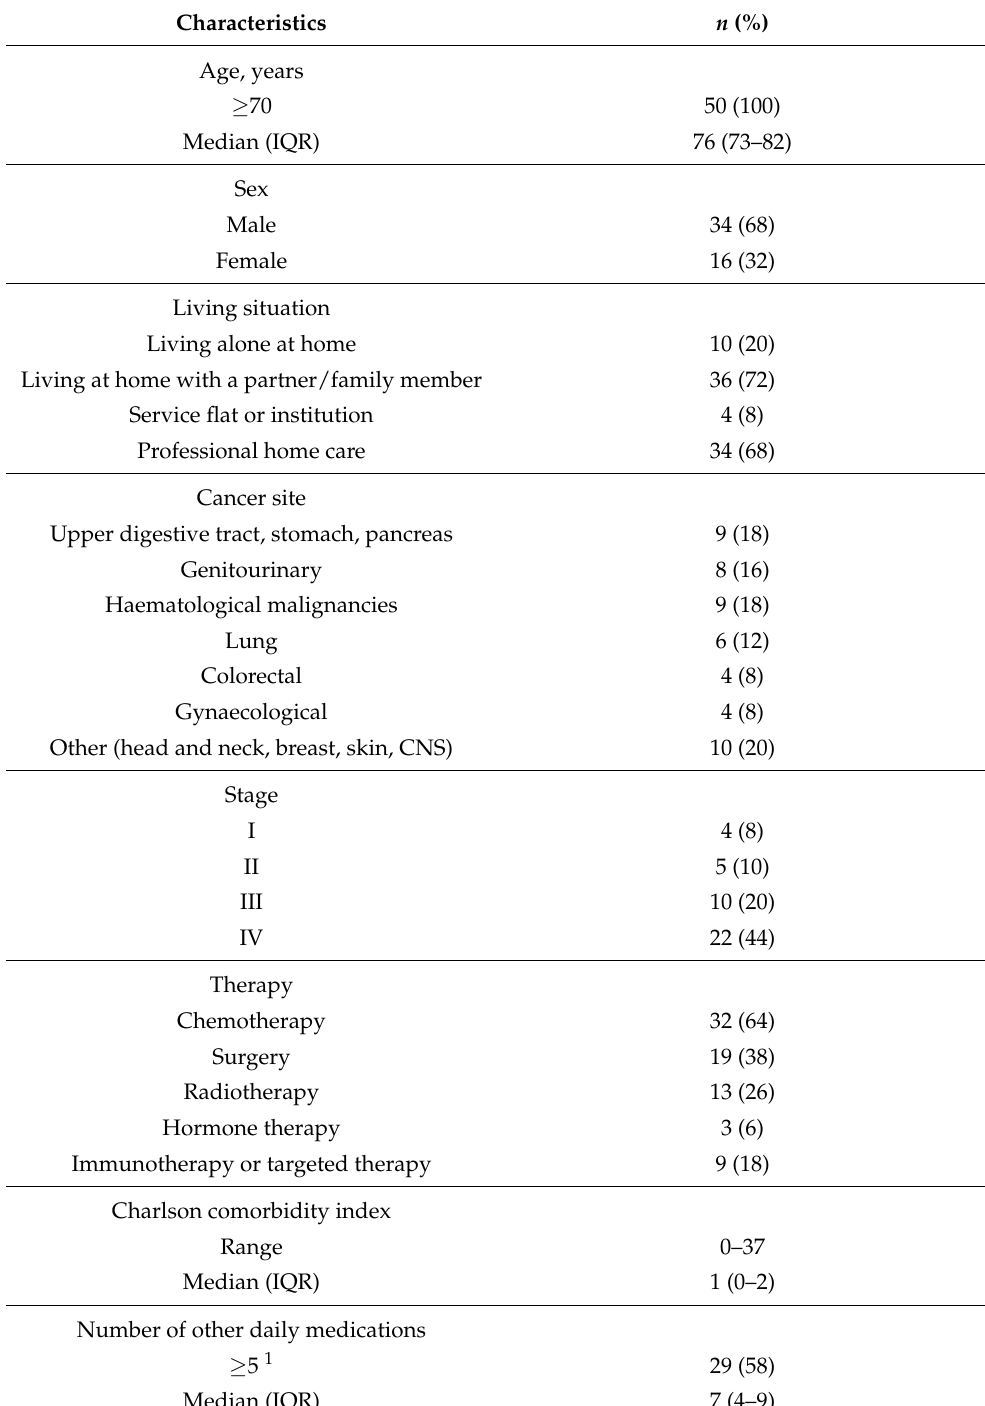
Table 1. Patient